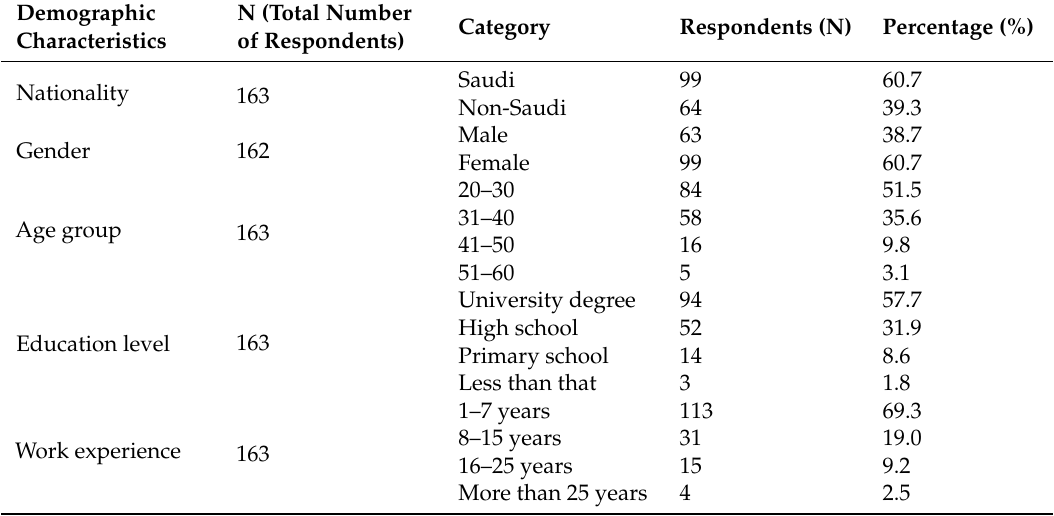
Table 1. The demographic characteristics of foodservices